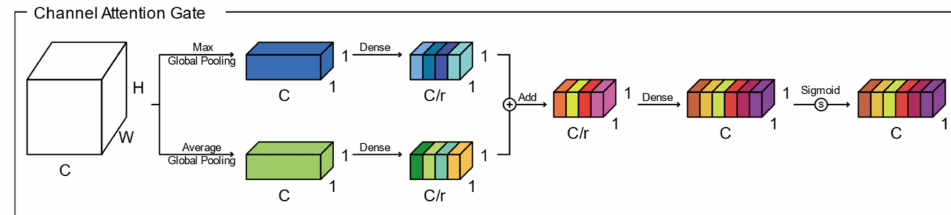
Figure 2. Channel attention gate.